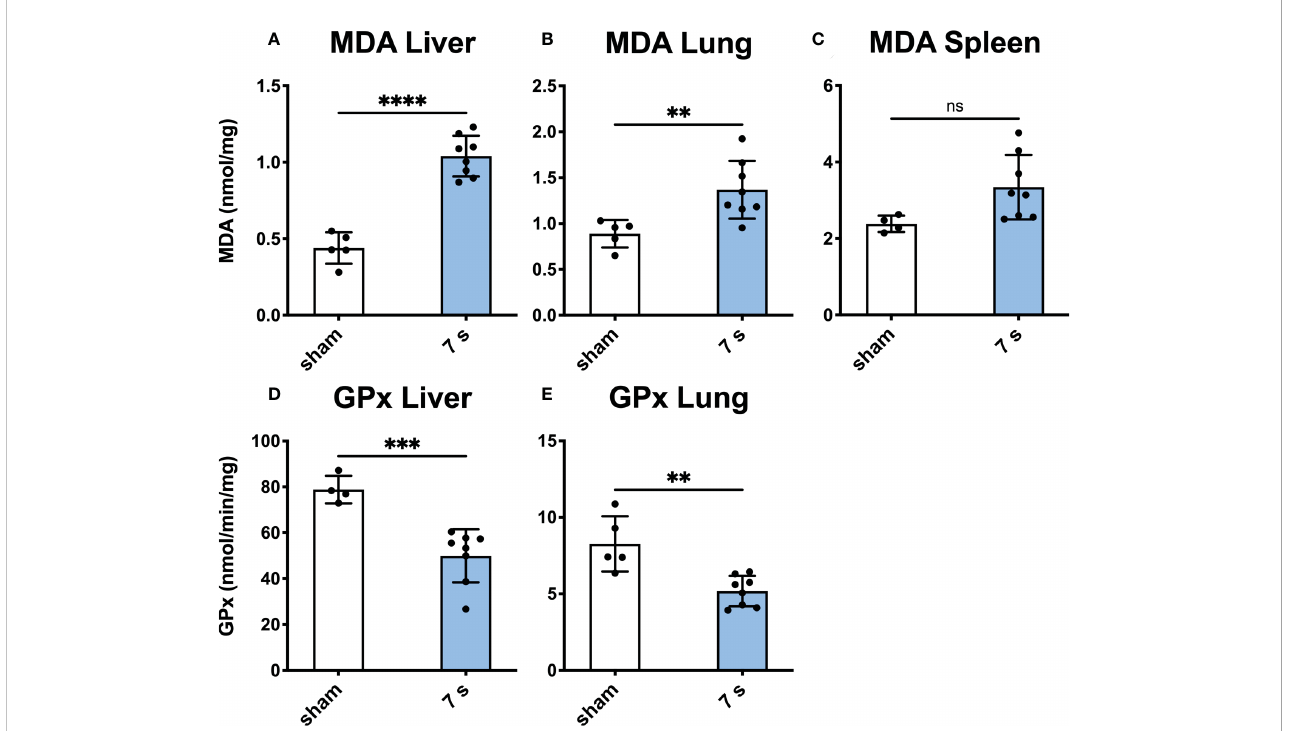
FIGURE 8 Scalding for 7 s induces oxidative stress in liver and lung after 24 h. MDA, a marker for oxidative stress reaction, was measured in the liver (A) , lung (B) , and spleen (C) . To measure changes in oxidative capacity, GPx was assayed in the liver (D) and lung (E) . In liver and lung, 7 s scald induces oxidative stress and reduces the oxidative capacity. Results are provided as mean ± SD. For comparison, an unpaired t -test was performed. The levels of signi fi cance: ns, not signi fi cant; **p < 0.01; ***p < 0.001; ****p < 0.0001.